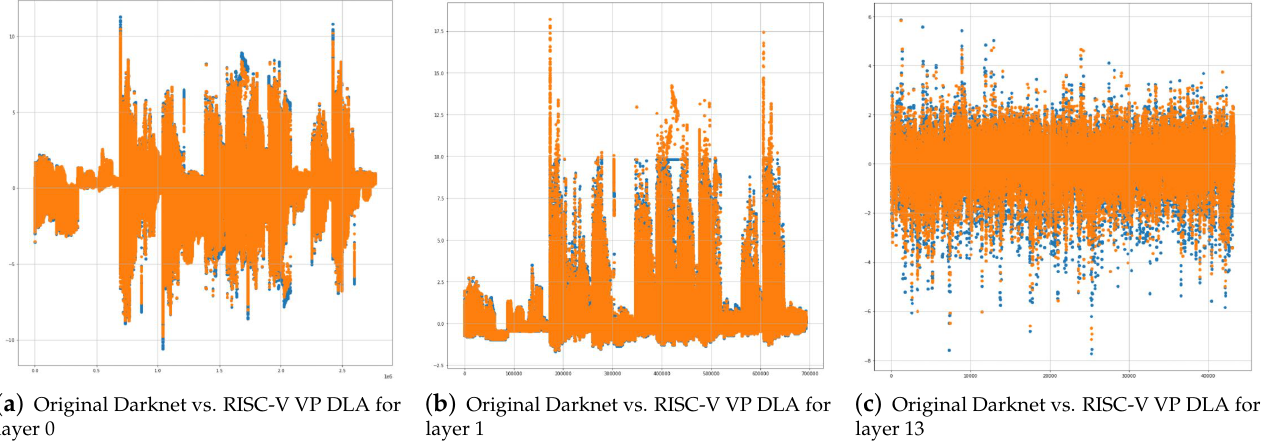
Figure 7. Comparison of each pixel values between RISC-V VP DLA system and Original Darknet Model running for layer 0, 1 and 13 of Darknet Yolo tiny v3 Nueral Network Model, which are convolution of 416 × 416 image with 16 filters ( a ), max pooling of 16 416 × 416 images ( b ), and convolution of 13 × 13 image with 1024 filters ( c ), respectively. Blue points represent pixels for original Darknet and orange points represent pixels for RISC-V VP DLA